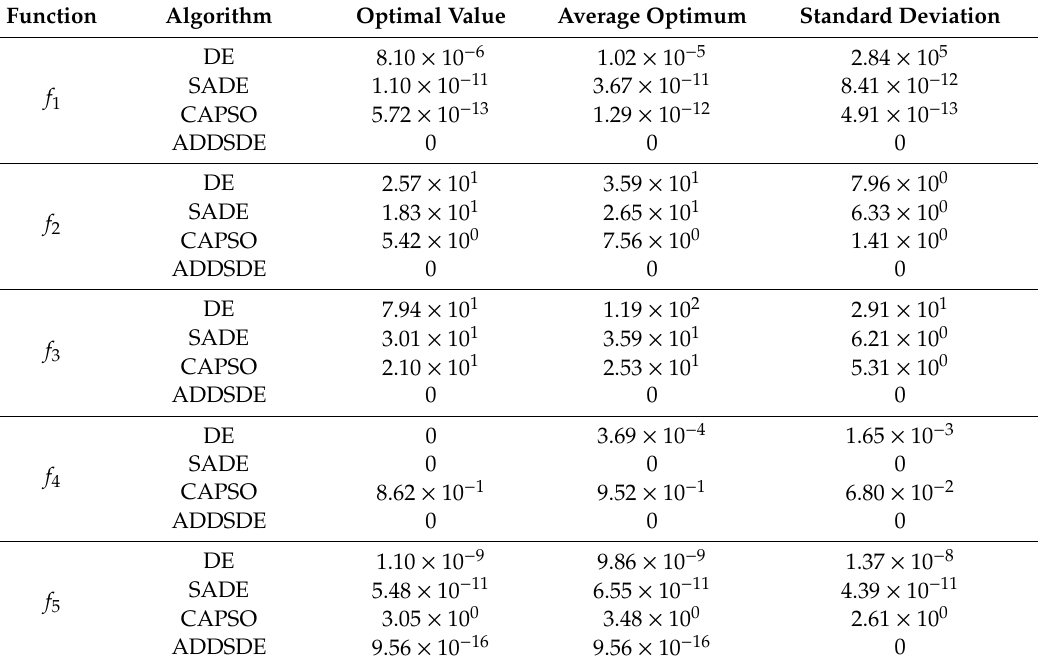
Table 2. 30-dimensional function optimization results.